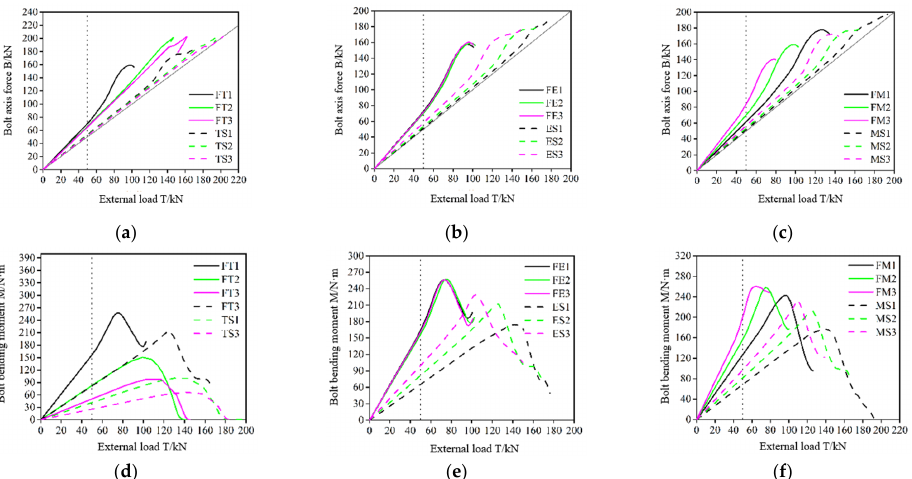
Figure 15. Bolt internal force curve under di ff erent parameters: ( a ) Bolt axial force curves at di ff erent thicknesses; ( b ) bolt axial force curves at di ff erent transverse distance ratios; ( c ) bolt axial force curves at di ff erent longitudinal distance ratios; ( d ) bolt bending moment curves at di ff erent thick- nesses; ( e ) bolt bending moment curves at di ff erent transverse distance ratios; ( f ) bolt bending mo- ment curves at di ff erent longitudinal distance ratios.